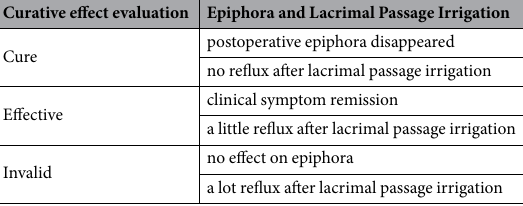
Table 1. The Curative effect